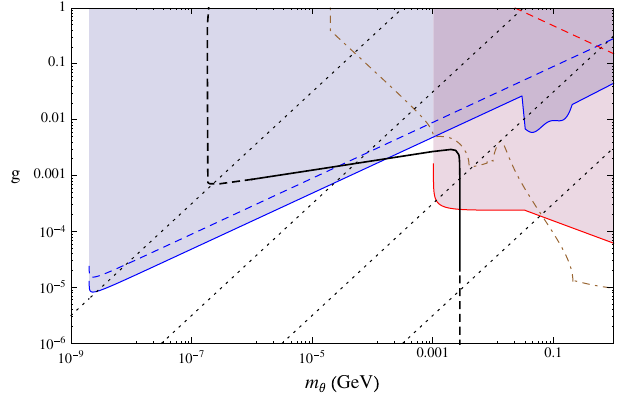
FIG. 4. The same as in Fig. 3, but for a heavier-neutrino-mass ¼ 1 eV . The extra red dashed line is the upper bound scale, m (cid:3) . (In the case of Fig. 3, the analog line from 1 = (cid:3) ð (cid:1) ! e þ e (cid:1) Þ > (cid:12) 0 > 1 GeV , which is not lies entirely in the region g > 1 and m (cid:1)